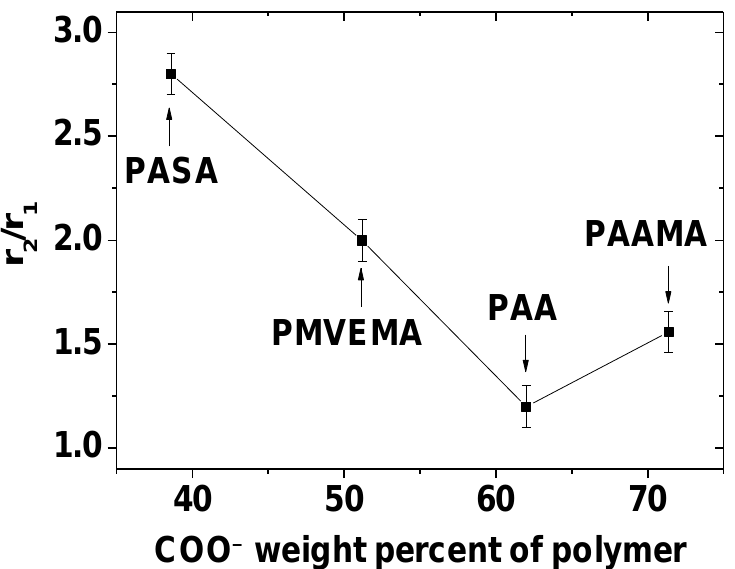
Figure 10. Plot of r 2 /r 1 ratio of polymer-coated Gd 2 O 3 nanoparticles dispersed in aqueous media as a function of COO − group weight percentage of polymers (polymer = PASA, PMVEMA, PAA, and PAAMA).